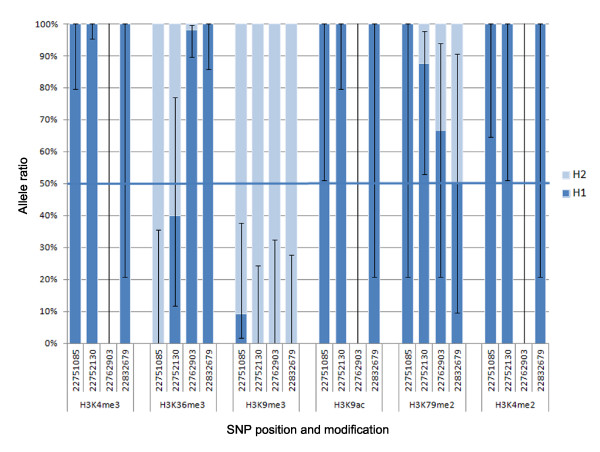
Allele ratio of the six histone modifications displaying the highest total coverage at four phased heterozygote sites at the Prader-Willi locus. Sites without a corresponding bar had no reads for the corresponding histone-modification map to that position. The 95% confidence intervals of the allele ratios are shown.